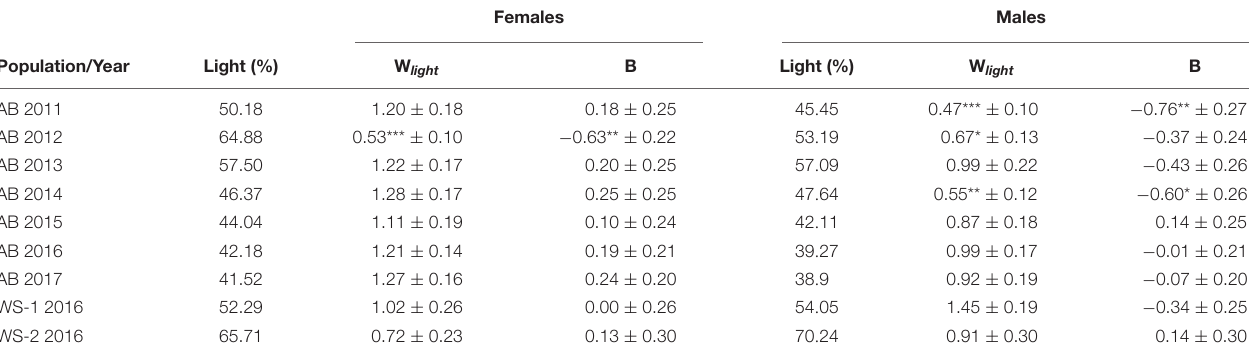
TABLE 2 | Sexual fitness estimates for females and males using the cross-product estimator ( W ± sd ) and logistic regression slope (B ± sd ) for light individuals. Females